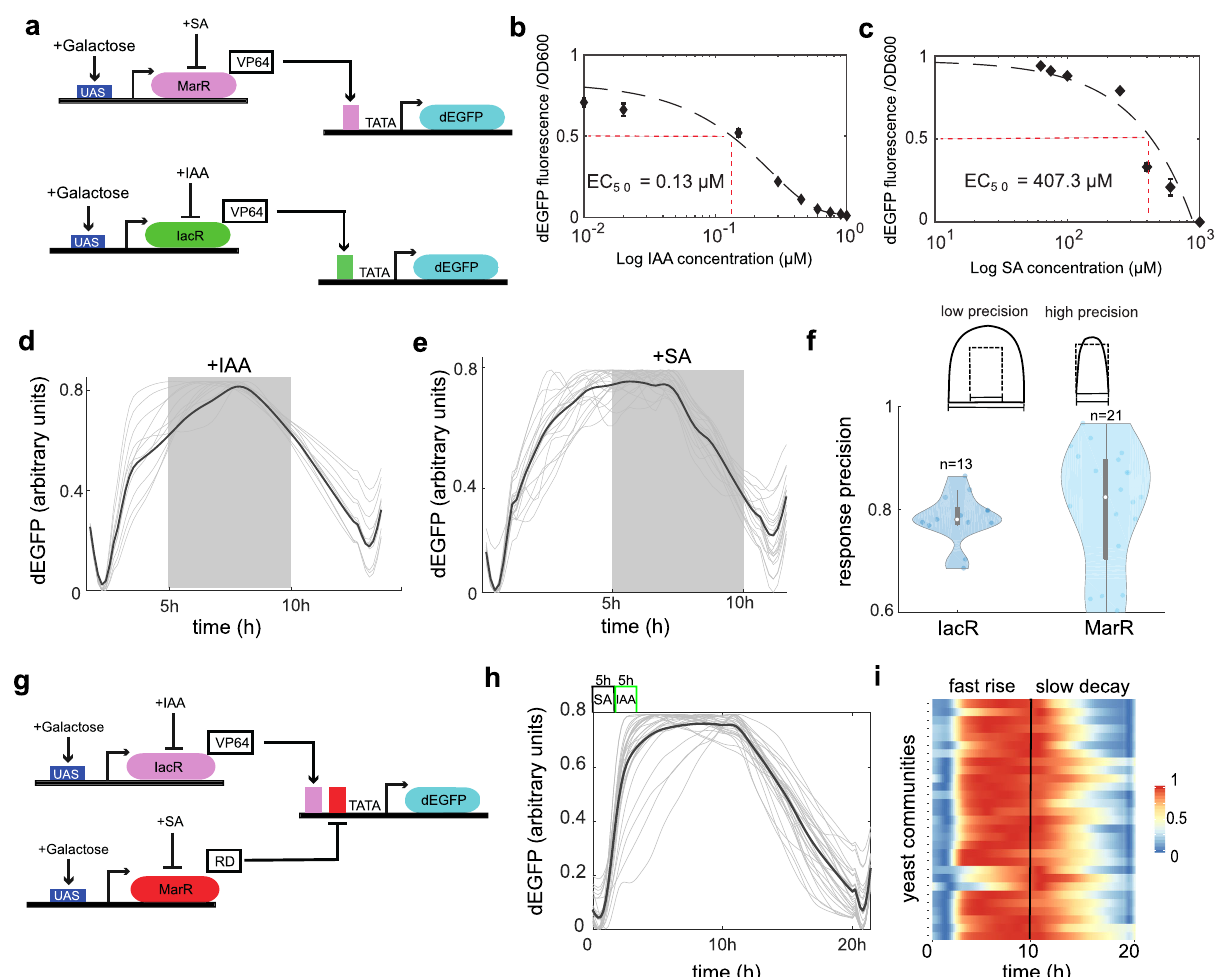
Fig. 1 Mar-type receptors show the speci fi c nonlinear switch-like dynamics in the presence of SA and IAA pulses. a Schematics of SA (top) and IAA (bottom) receptors. MarR (pink) or IacR (green) repressors are tagged with a synthetic VP64 viral transactivation domain, nuclear localization signal (NLS), and PEST degron. Galactose is used to induce the transcription of both receptors through galactose-responsive UAS sequences(blue). The green fl uorescent reporter (dEGFP, cyan) contains an uncleavable ubiquitin (G76V) tagged to N-terminus of enhanced GFP (EGFP) that is driven by the minimal promoter with either MarR (pink bar) or IacR (green bar) operators placed directly upstream of TATA-box. b , c Response kinetics of IacR module to IAA ( b ) and MarR module to SA ( c ) are shown. Note a dynamic range of two-orders of magnitude for physiological concentrations of SA and IAA. Means (diamonds) and standard errors bars are from three independent replicates. d , e dEGFP fl uorescence time pro fi les for IacR ( d ) and MarR ( e ) receptors. Stimulus was provided as indicated: 5 h (gray box) chemical pulse followed by 5 h reset phase (10 h cycle). Note, time-lag in both activation and repression of dEGFP reporter. f Response precision plots for both receptors ( n = 13, n = 21 traps). In the scheme, the input pulse is shown with a dashed rectangular pro fi le and expected dEGFP output response with a solid curve. Violin plots represent medians (white dots), interquartile zones (gray bars) and 95% con fi dence levels (solid gray line). Gray contours show density plot boundaries. g Schematics of dual-receptor circuit with IacR activator (pink) and MarR repressor (red) used to explore switching dynamics. h dEGFP dynamics are controlled by successive switching of SA and IAA levels (amplitudes: 500 μ M SA and 1 μ M IAA) in the 10-h period. Mean pro fi les across yeast colonies ( n = 29) are shown as black line. Note a characteristic switch-like response dynamics. i A heat map (0 – 1) of normalized dEGFP fl uorescence in distant communities ( n = 29). Synchronous switching was observed across yeast colonies. For refence dashed line indicates the end of chemical stimulus cycle. Source data are provided in the Source Data fi